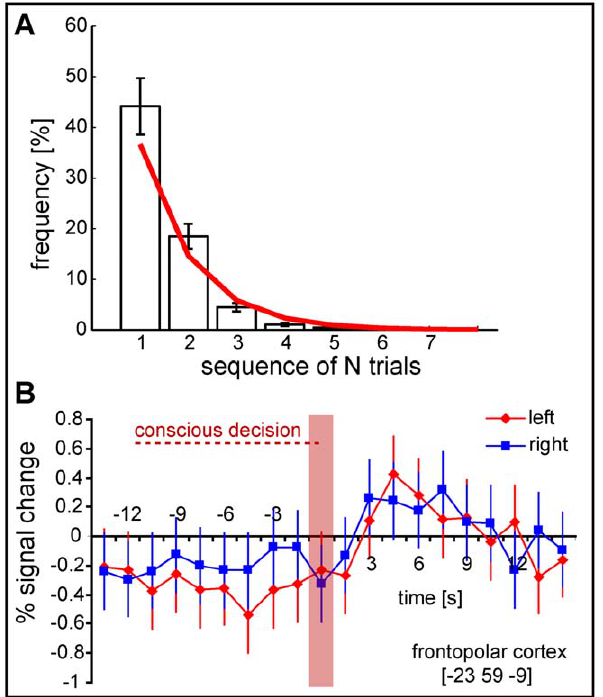
Figure 5. Sequence length and univariate fMRI results. A) Histogram of sequence length. Displayed is the average percentage of sequences of N trials of the same decision (left or right) before switching to the other decision. It resembles an exponential distribu- tion; fitted model: f(x)=100*c*e 2 c*x , with c=0.917, RMSD=2.739 (red curve). This suggests that subjects made random decisions. Error bars are standard errors. B) The graph shows the percent signal change (average BOLD estimates from 20 FIR predictors) during left-decision and right-decision trials for the central searchlight voxel [ 2 23 59 2 9] that demonstrated the highest accuracy in decoding the decision outcome prior to the conscious decision. For both conditions, the signal increased only after the decision (red bar) and came back down to baseline in the next ten seconds. Significant differences between left and right decisions were not found for this cluster. No region could be found in the imaged volume that displayed a difference between left and right, even when a liberal threshold of p , .001 (uncorrected) was used. Time-points preceding the conscious awareness of the intention are labelled as negative numbers (units=seconds, relative to decision); time-points following the decision are therefore positive. One time-bin corresponds to 1.5 s. Coordinates are given as MNI